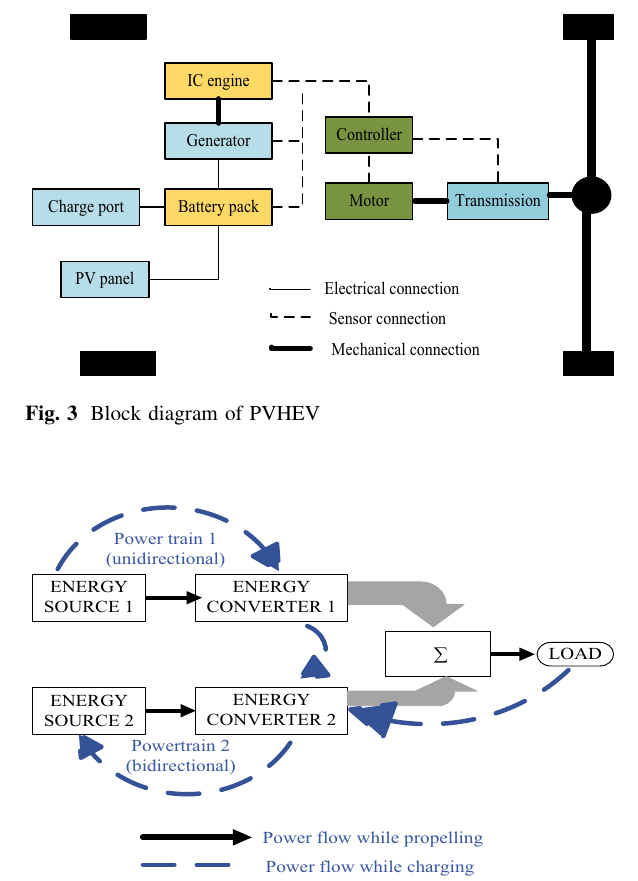
Fig. 4 Patterns of power